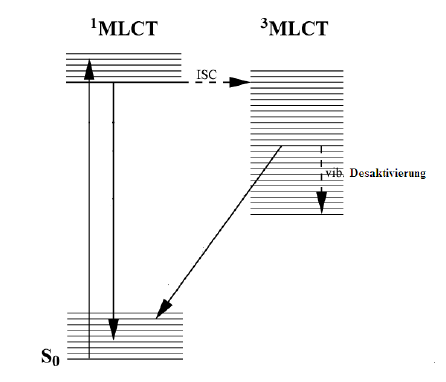
Figure 2. Formation of the 3 MLCT state via photon